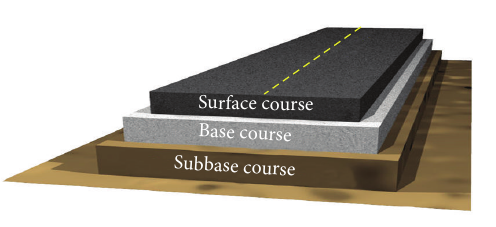
Figure 1: Typical flexible pavement